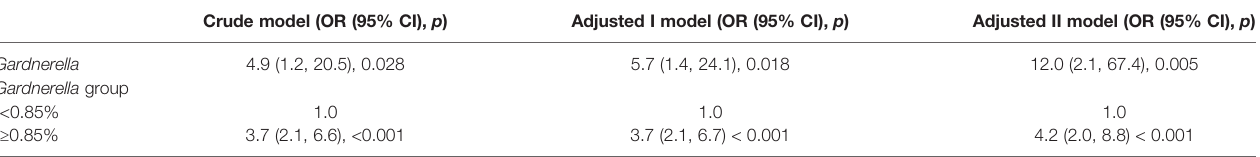
TABLE 2 | Multivariate logistic regression analysis for the relationship between the relative abundance of Gardnerella and TP. Crude model (OR (95% CI), p